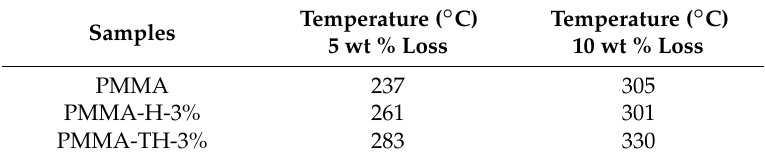
Table 2. The decomposition temperatures of the samples at 5 wt % and 10 wt % loss.